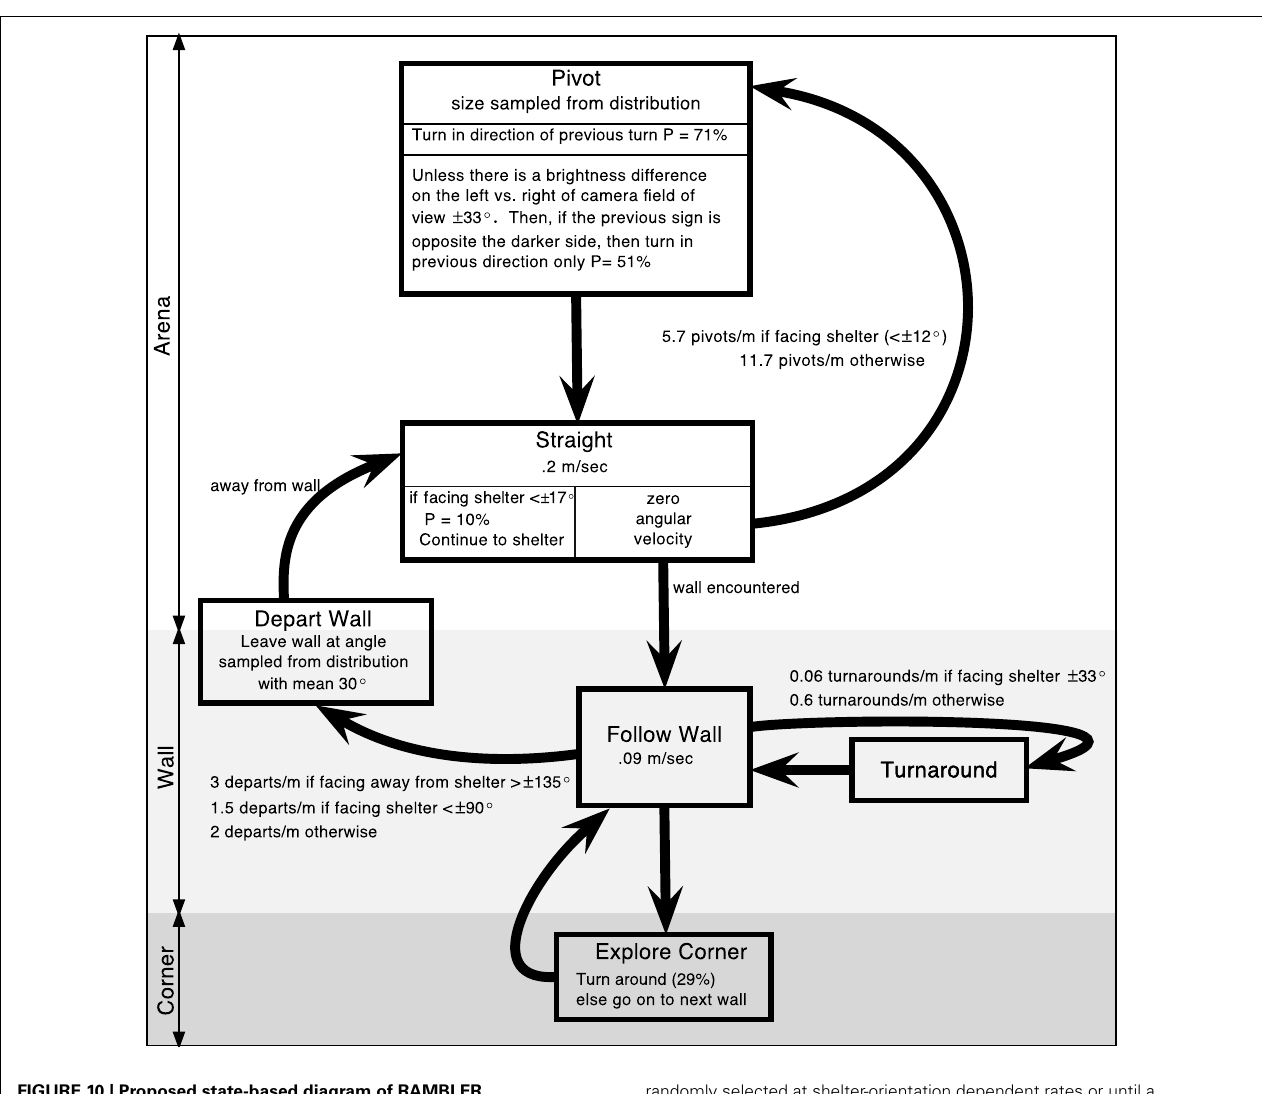
FIGURE 10 | Proposed state-based diagram of RAMBLER, randomized algorithm mimicking biased lone exploration in roaches. There are states for along the wall, in the corner, and in the arena. “FollowWall” continues until a turnaround or departure is